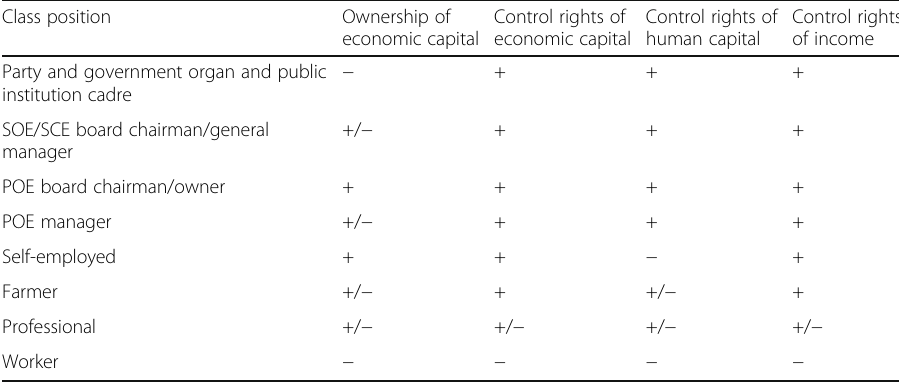
Table 2 Power basis of class position and its economic interests Class